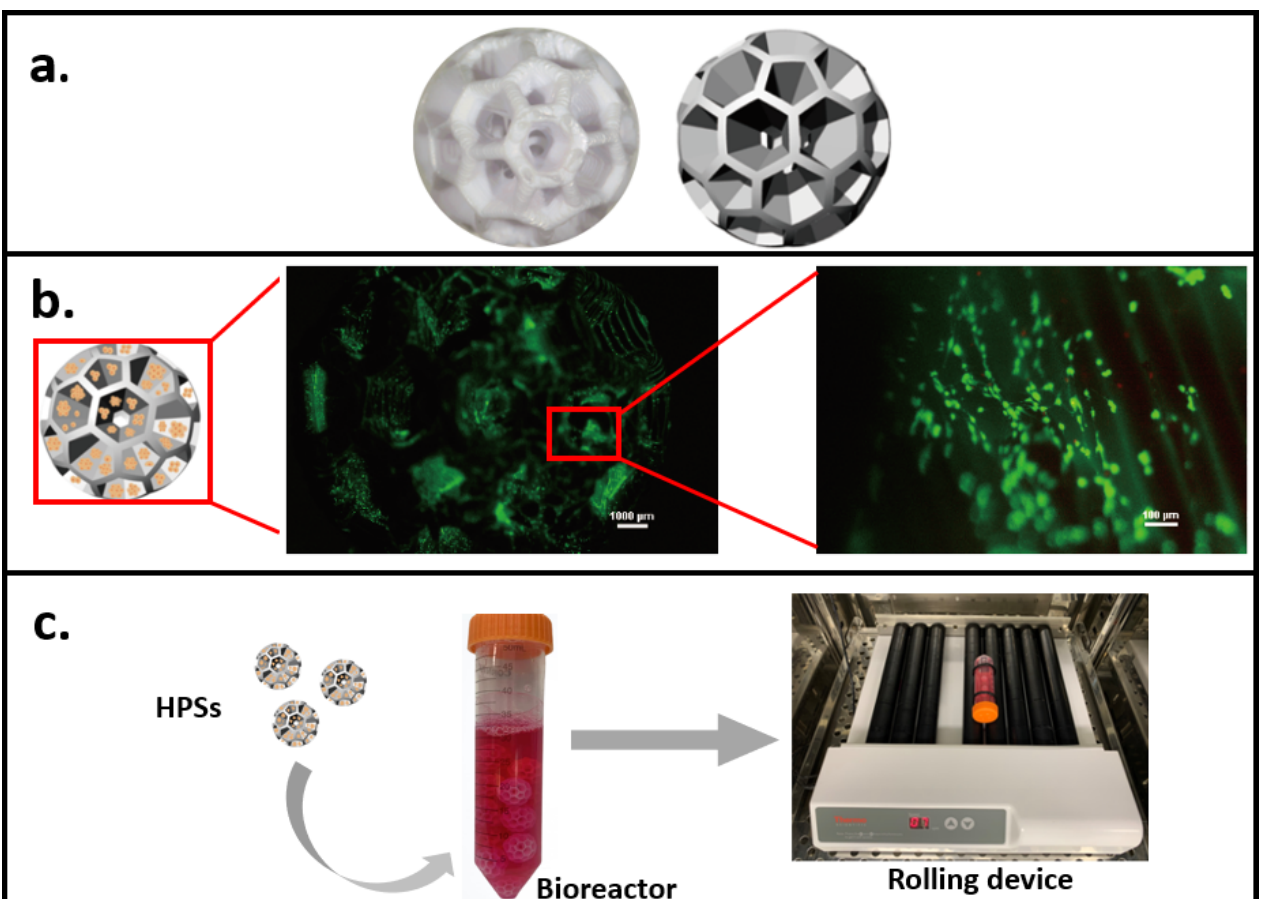
Figure 2. A novel 3D dynamic cell culture method. ( a ) 3D printed hollow porous scaffold (HPS) as cell carrier. ( b ) Fluorescent images showing cell (staining with FDA) growth on HPS. ( c ) The 3D dynamic culture system consists of the cell-seeded HPS, a bioreactor, and a rolling device.